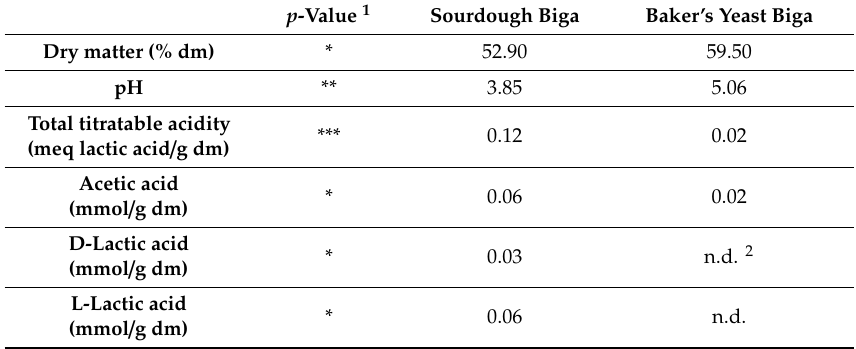
Table 2. Physical and chemical characterization of sourdough and baker’s yeast biga: dry matter (dm %), pH, total titratable acidity (TTA), and main fermentative metabolites. Data presented are the mean of three